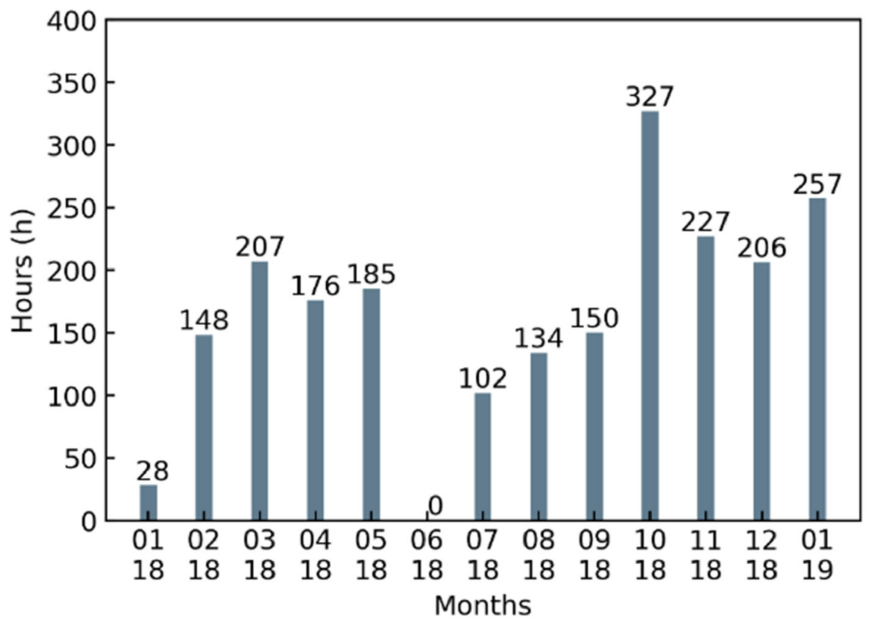
Figure 2. Data coverage from 26 January 2018 to 16 January